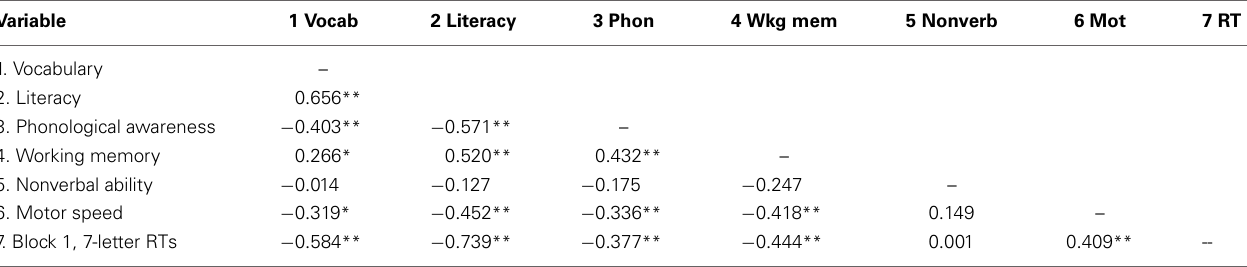
Table 2 | Correlations among the predictor variables, and between the predictor variables and naming RTs for 7-letter nonwords in block 1 of day